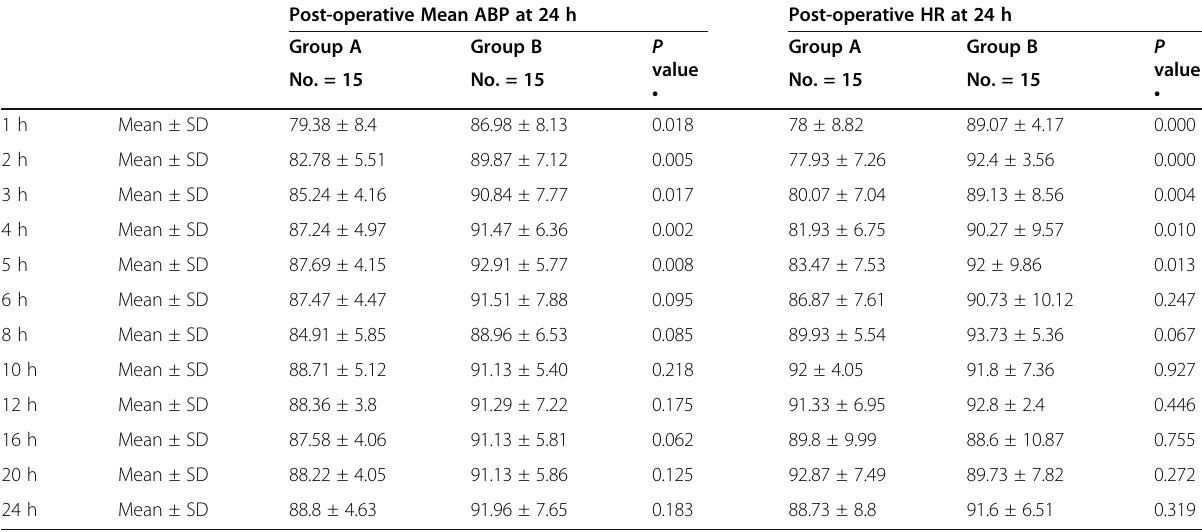
Table 4 Comparison between group A (Pecs) and group B (TPVB) regarding mean arterial blood pressure and HR changes during 24 h post-operative